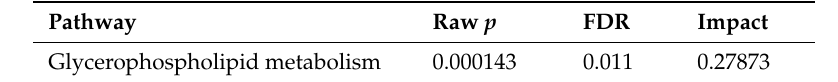
Table 5. Altered metabolic pathways regulated by BA-12 based on UPLC–TOF-MS metabolomics. FDR—false discovery